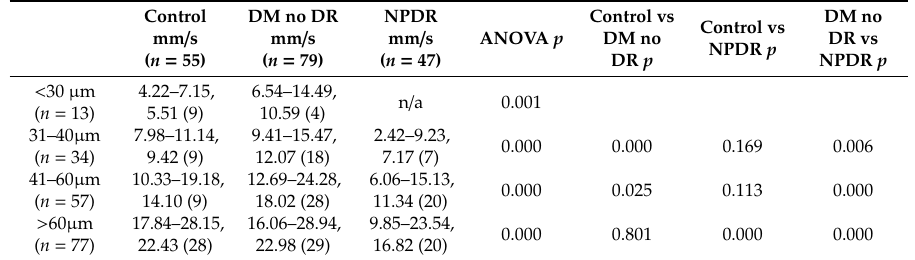
Table 3. Summary of arteriolar blood velocity by vessel diameter groups, comparing healthy Controls, diabetes without retinopathy, and non-proliferative diabetic retinopathy.